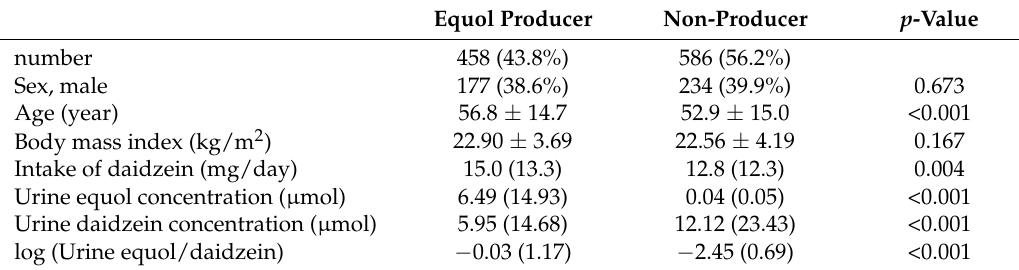
Figure 4. The relative abundances of different gut microbiota between the equol producers and the non-producers ( a ) at the phyla level and ( b ) genera level. Table 1. Characteristics of equol producer and